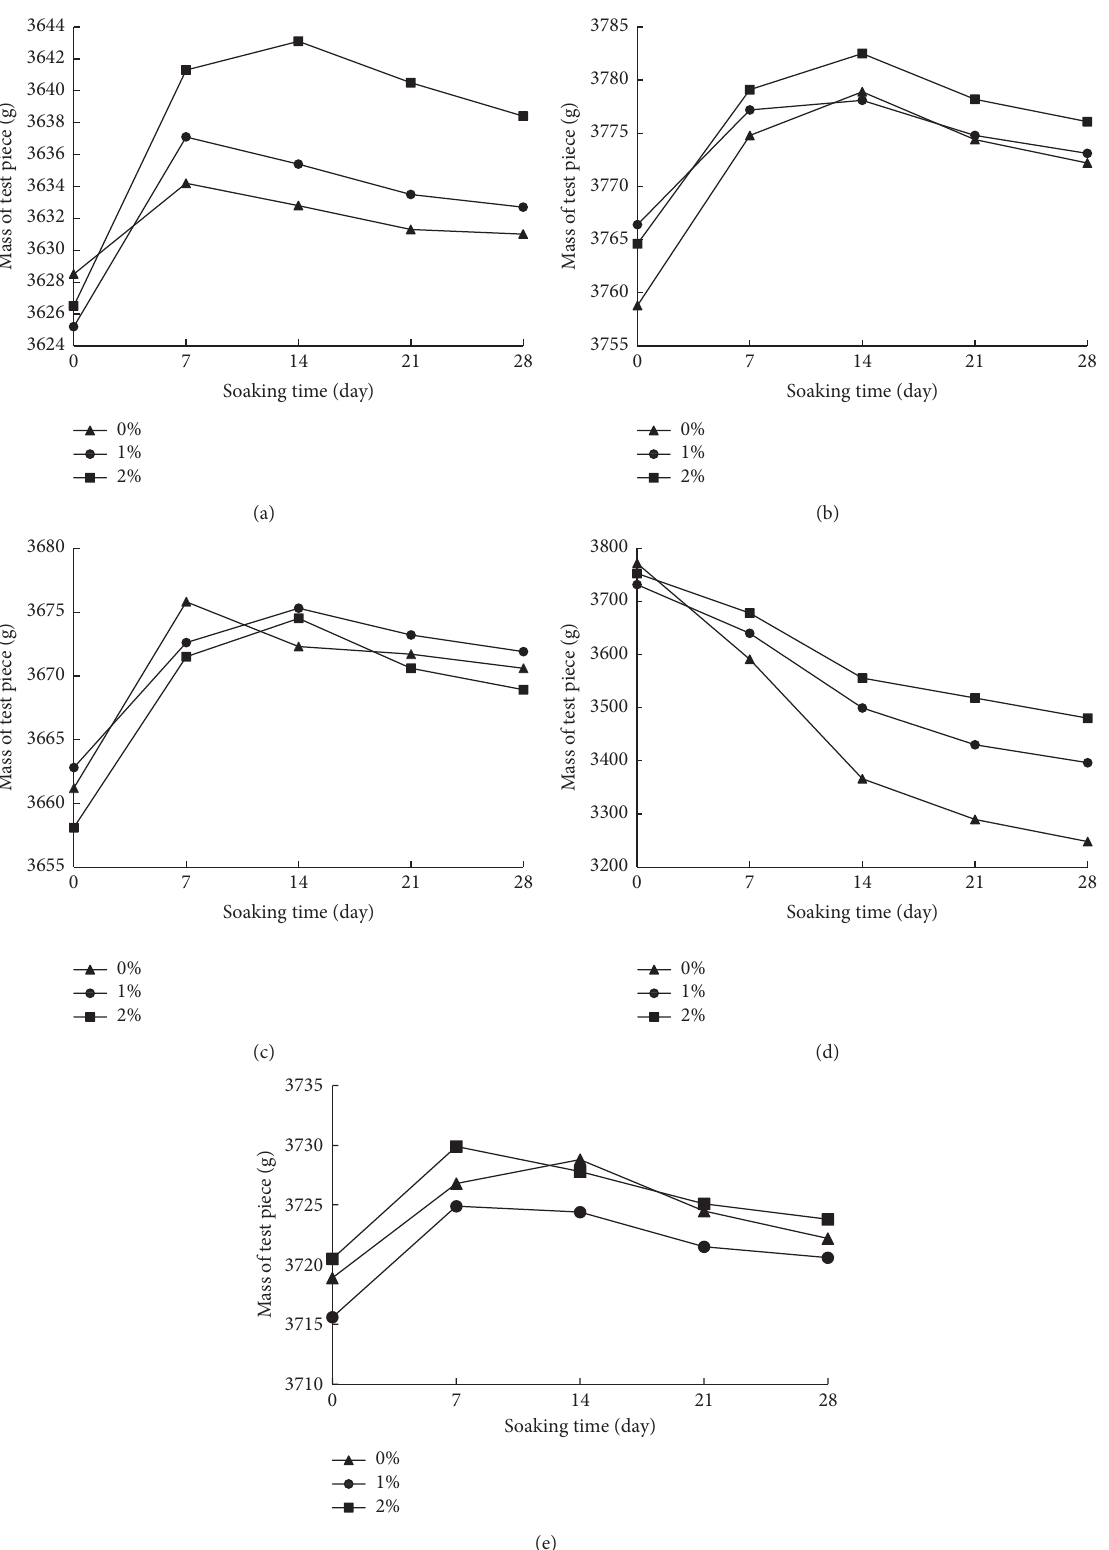
Figure 10: Mass change of specimen in various solutions. (a) Mass change of specimen soaked in water. (b) Mass change of specimen soaked in NaCl solution. (c) Mass change of specimen soaked in Na 2 SO 4 solution. (d) Mass change of specimen soaked in sulfuric H 2 SO 4 solution. (e) Mass change of specimen soaked in NaOH